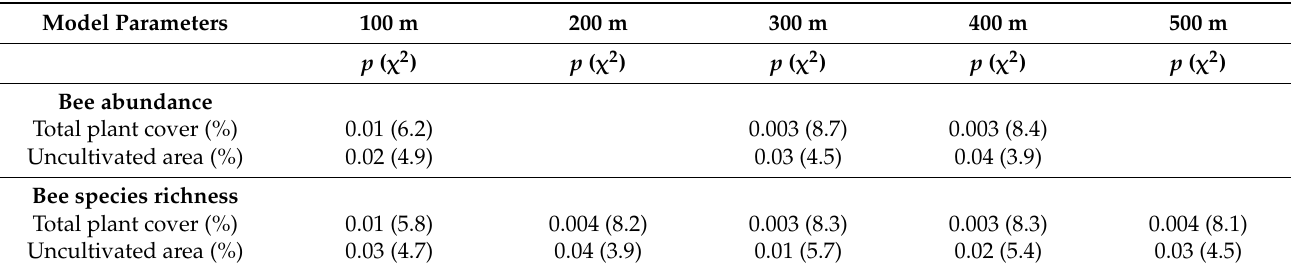
Table 1. Best-fitted GLMM models ( ∆ AIC < 2) for wild bee abundance and species richness. Each equivalent model includes total plant cover (herbaceous and woody at the plot scale) + uncultivated area in a specific buffer range (100/300/400 m radii for bee abundance; 100/200/300/400/500 m radii for bee